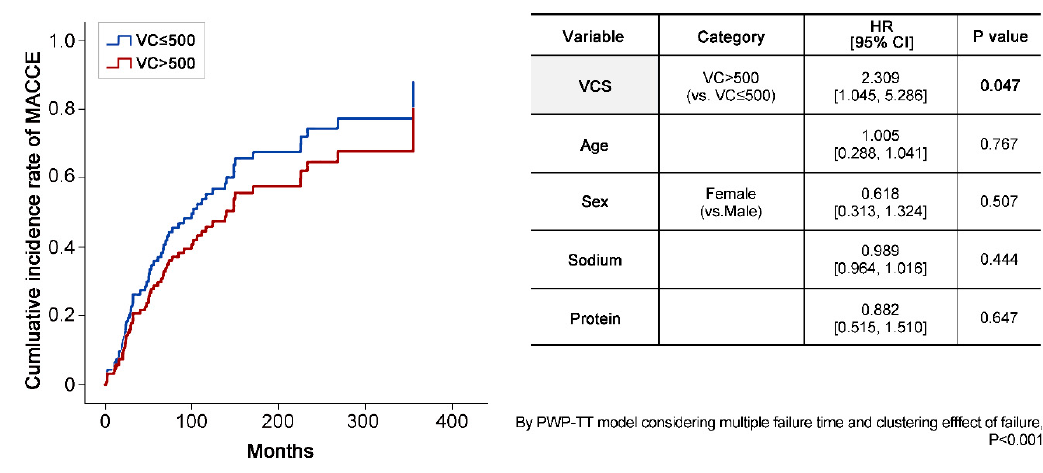
Figure 4. The incidence of MACCE in the two VCS groups.